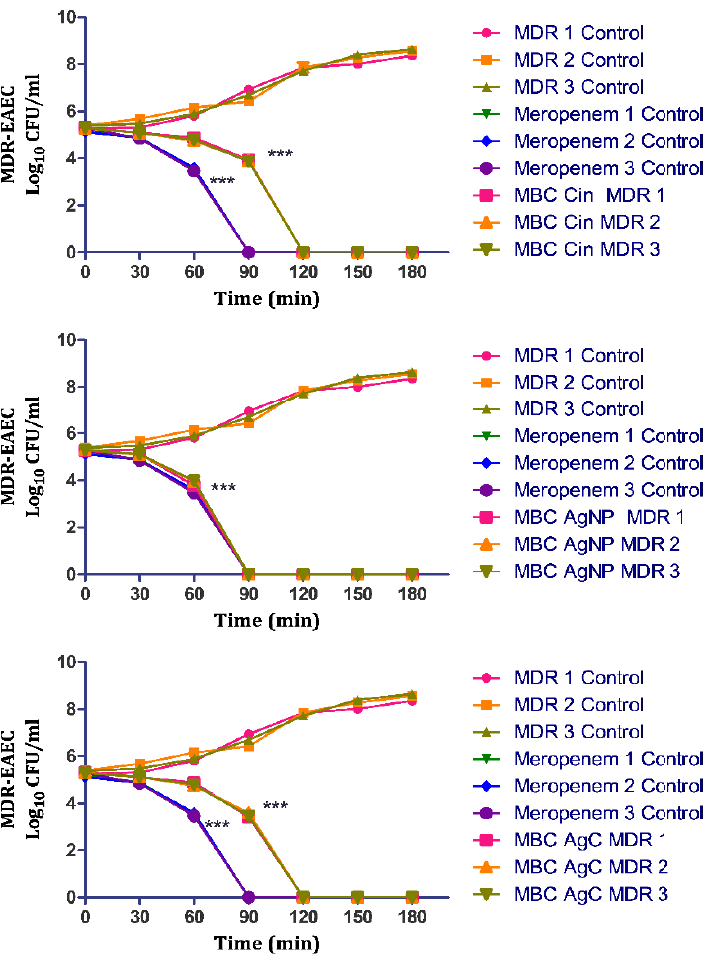
Figure 4. In vitro dose- and time-dependent time-kill assay of MDR-EAEC isolates co-cultured with 1X MBC of cinnamaldehyde (Cin), AgNPs and AgC in CA-MH broth at 37 °C under static conditions with respective controls of MDR-EAEC isolates (untreated and meropenem-treated). Data expressed as the mean ± standard deviation (log 10 CFU/mL) of three independent experiments (*** p < 0.001). Error bars too close to display.